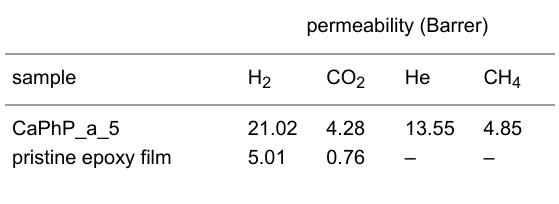
Table 2: Results of gas permeability measurements. The permeability of pristine epoxy film for He and CH 4 were not measured. permeability